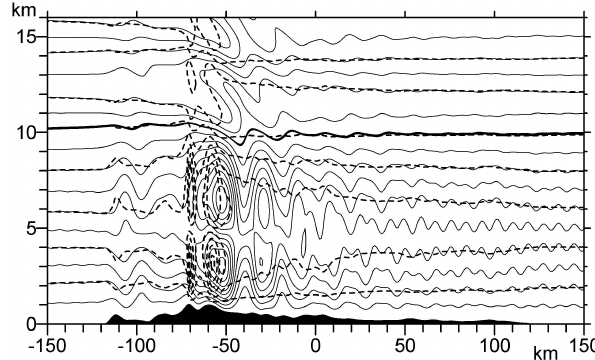
Fig. 8. Streamlines over the Scandinavian mountains, case b. No- tations are the same as in Figs. 5a–d. The flow fields correspond to the point A in Fig. 7 near the second quasi-resonant peak of C D . Flow is directed from left to right. The values of the drag coefficient are 20.0 and 9.8 for the hydrostatic and non-hydrostatic solutions,